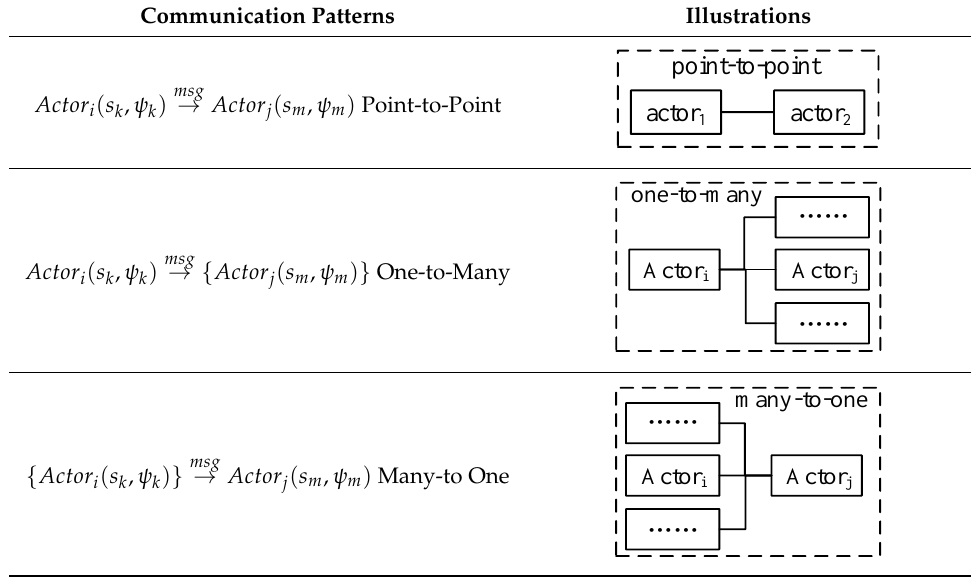
Table 2. Three types of communication for definition.